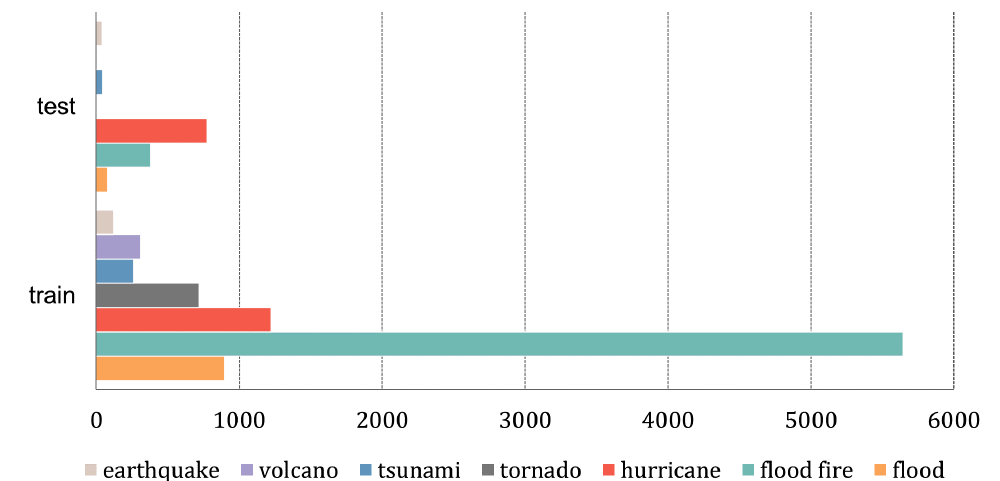
Figure 12. The distribution of disaster categories in xBD